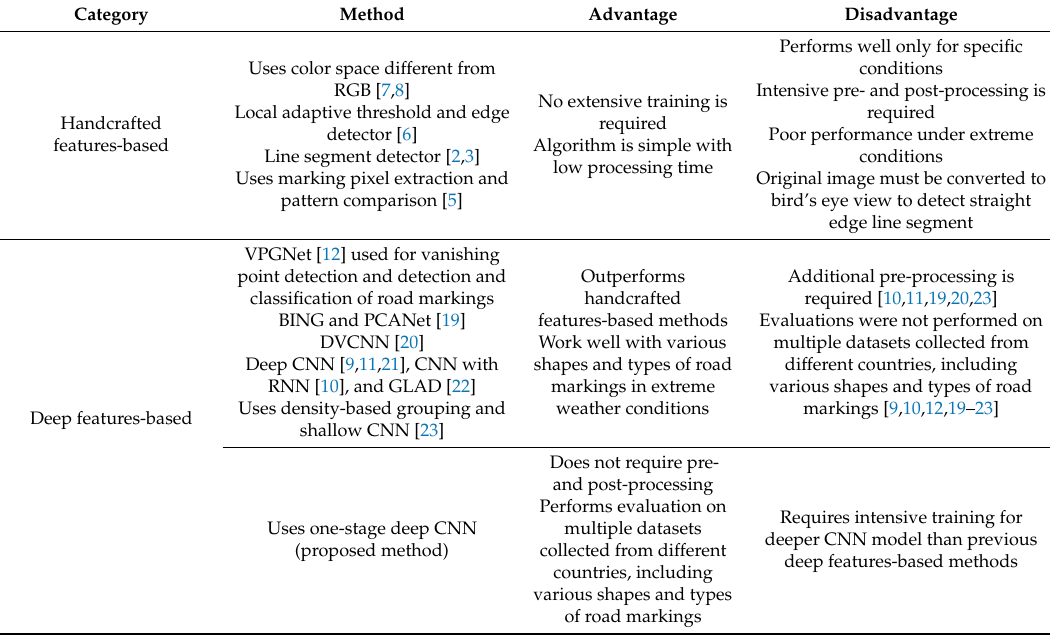
Table 1. Comparisons between existing method and the proposed method for detection and classification of road